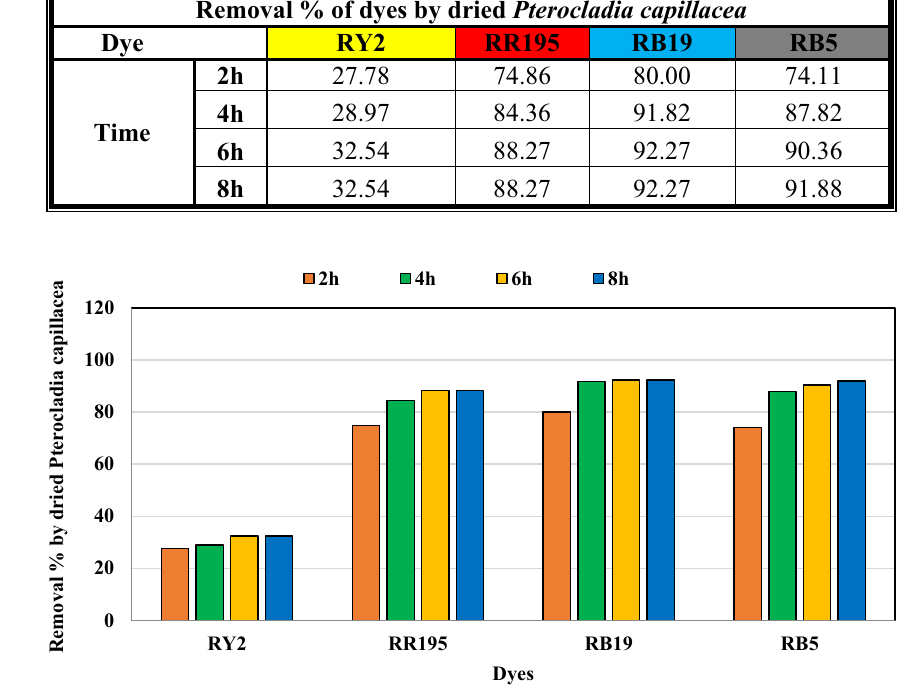
Fig. 16 Effect of contact time (at optimized conditions) on the removal percentages of the four studied dyes by dried Ptero- cladia